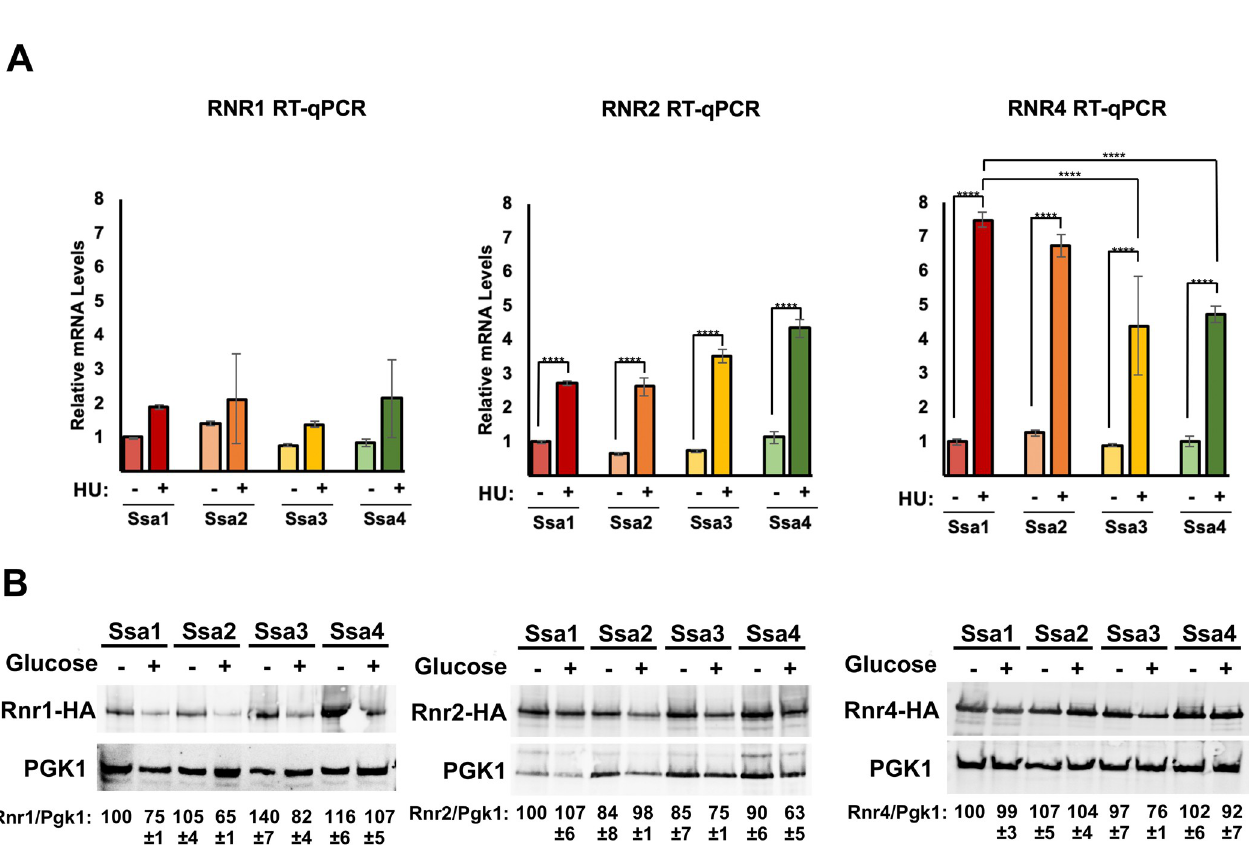
Fig 3. Transcription and stability of RNR subunits are altered in cells only expressing one Ssa paralog. (A) Quantitation of RNR1 , RNR2 and RNR4 mRNA levels in Ssa1, 2,3 or 4-expressing yeast. Levels of RNR1 , RNR2 and RNR4 mRNAs in Ssa1, 2,3 or 4 cells were determined by reverse transcription and RT- qPCR. Signals of RNR1 , RNR2 and RNR4 were normalized against that of ACT1 in each strain, and the resulting ratios in Ssa1 cells were arbitrarily defined as onefold. Data are the average and SD from three replicates � , P � 0.05 �� , P � 0.01; ��� , P � 0.001; ���� , P � 0.0001 as compared to indicated strains. (B) RNR subunit stability in yeast expressing single Ssa paralogs. Ssa1, 2,3 or 4-expressing cells transformed with either pGAL1-HA-Rnr1, 2 or 4 plasmids were grown to mid-log phase in YP Galactose medium. RNR expression was shut off by addition of 2% glucose to cultures. Cell lysates from these samples were analyzed over time by Western Blotting for the stability of HA-RNR subunit (HA antibody) and loading control (PGK1). The ratio of RNR/PGK was quantified and determined from three biological replicate experiments.